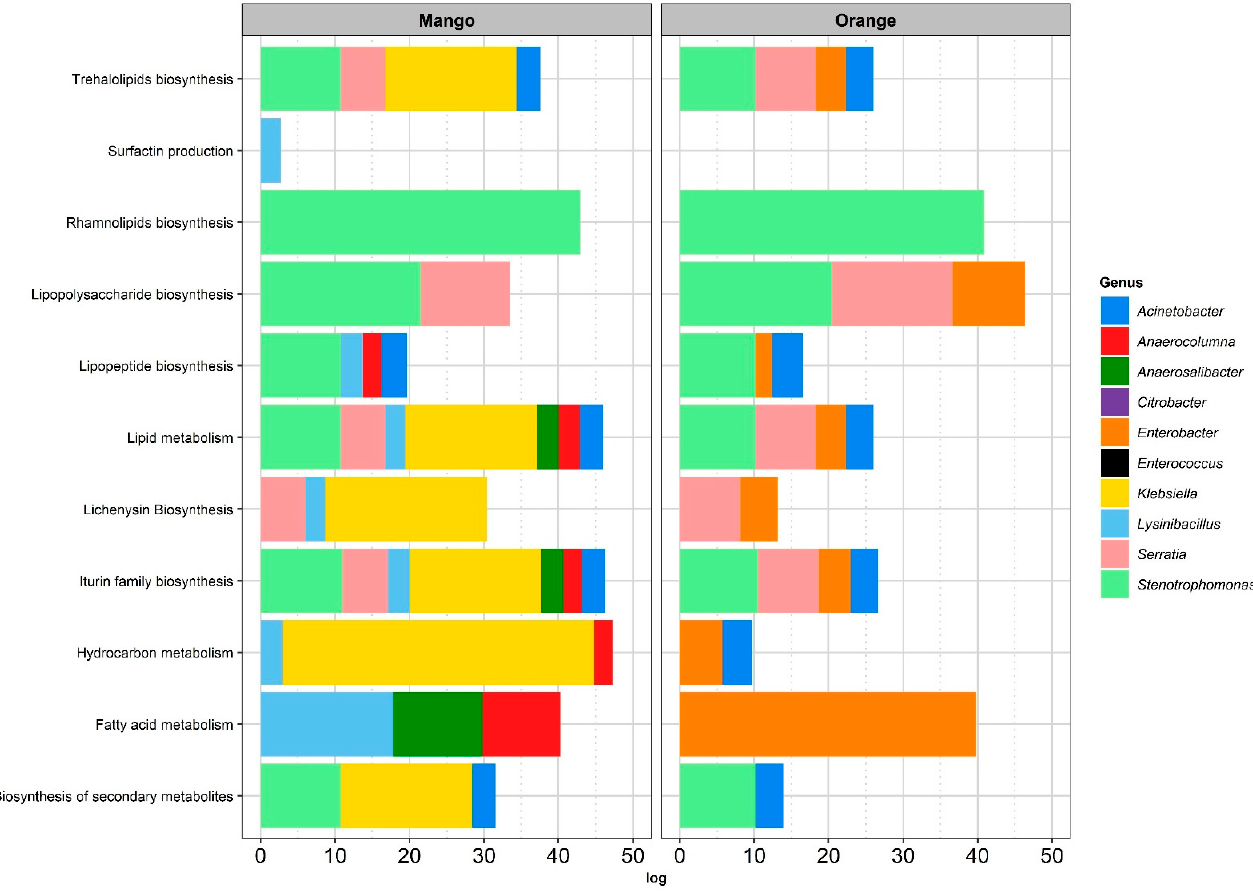
Figure 4. Metabolic activities from specific pathways related to the production of biosurfactants associated with the 10 most abundant genera.